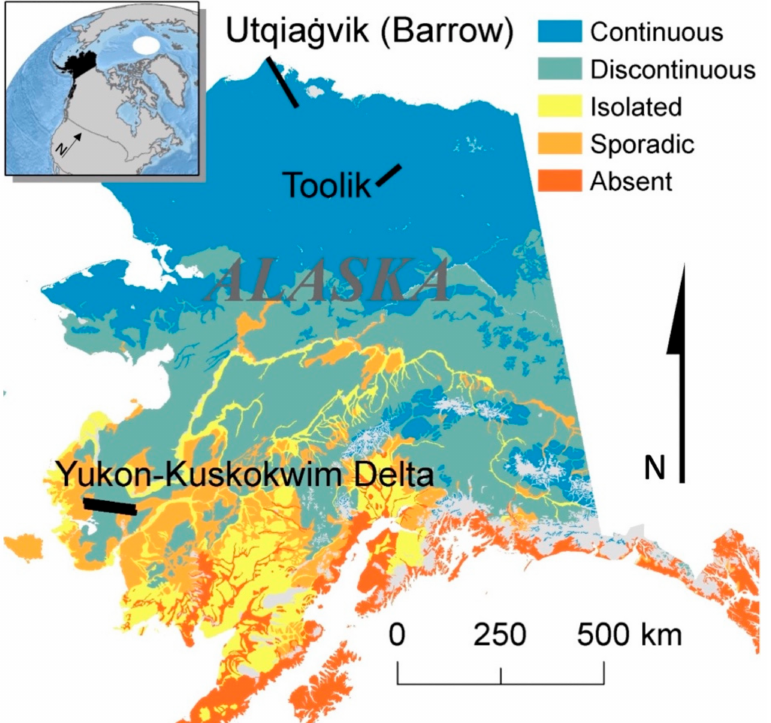
Figure 1. Airborne SAR swaths (black patches) and the permafrost classification across Alaska, USA